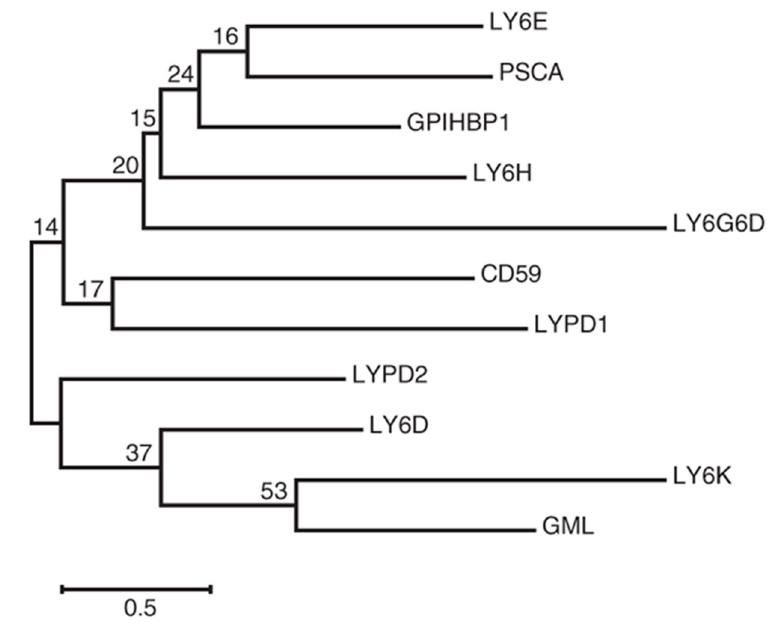
Figure 2. Phylogenetic analysis of human ly6 / uPAR family proteins constructed by using the maximum likelihood method based on the Jones–Taylor–Thornton (JTT) matrix-based model. Adapted from reference [27].